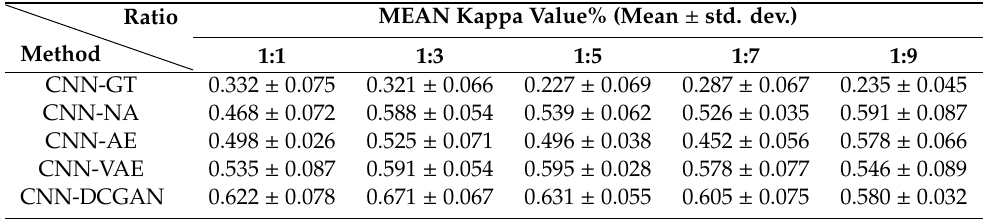
Table 9. Mean kappa value of the methods for the BCI competition IV dataset 2b (baseline: 0.4789 ± 0.077%).